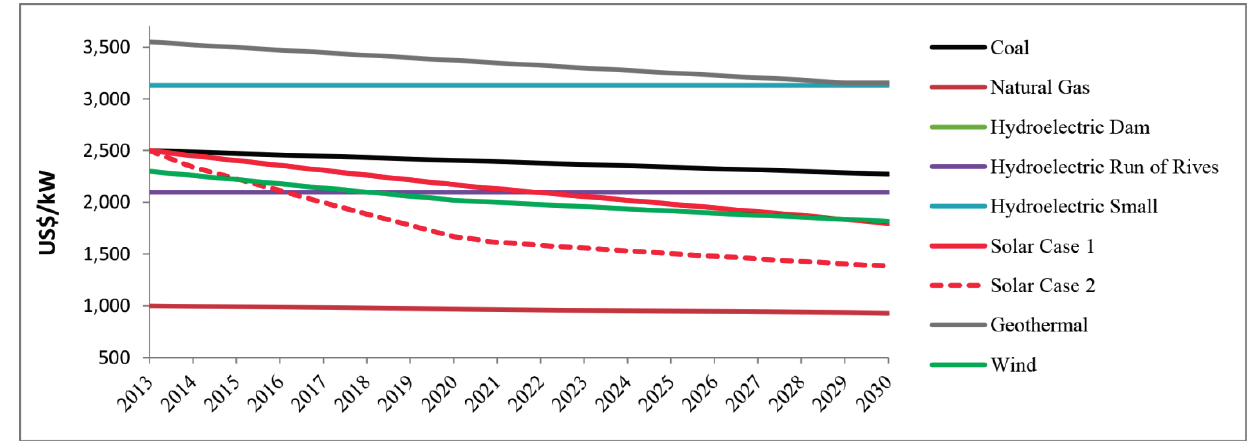
Figure 14. Investment cost